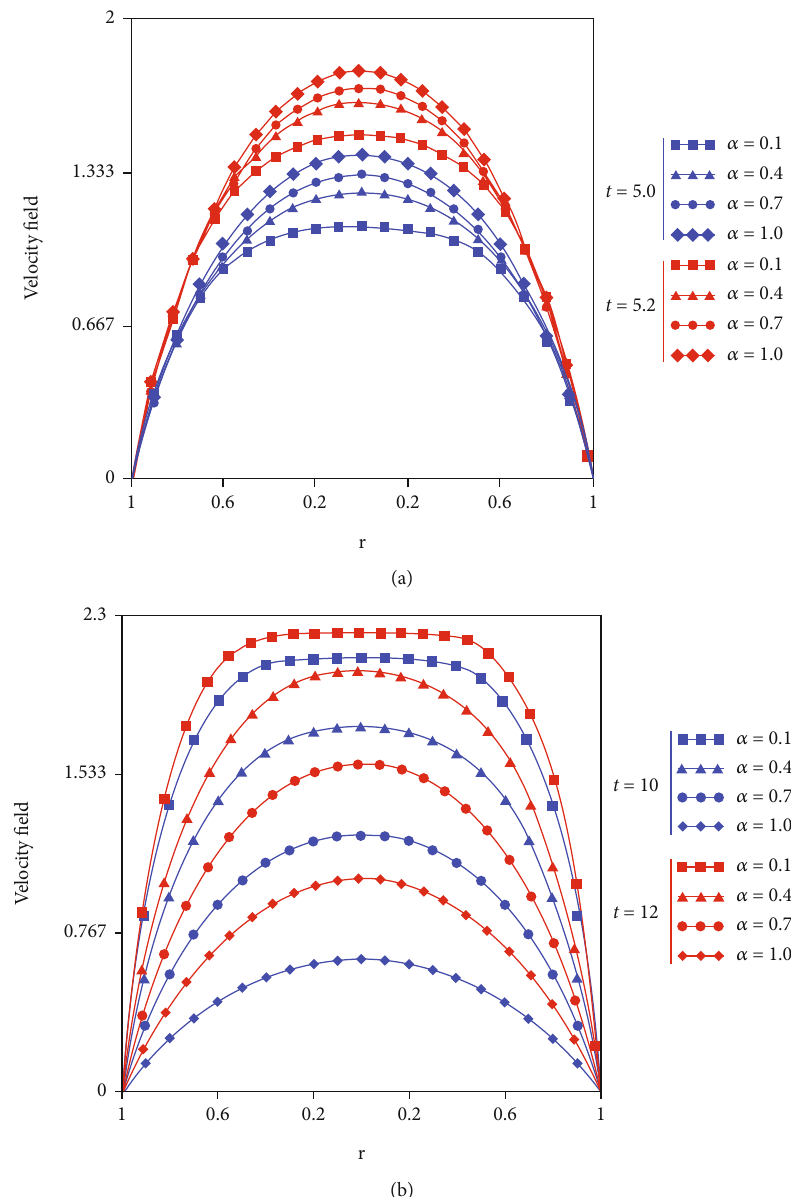
Figure 2: Pro fi les of dimensionless velocity for α versus r at Re = 2 : 5, Ha = 0 : 5, K = 1, n = 0 : 8, for small and large values of time t